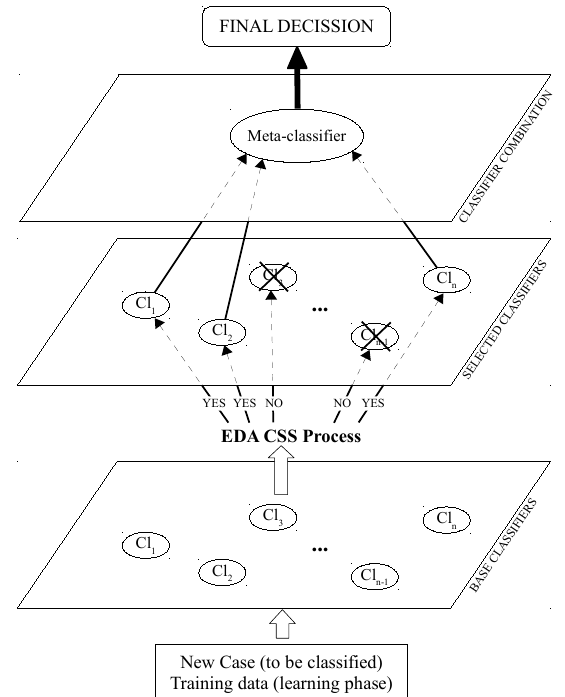
Figure 2. Classifier subset selection stacked generalization.